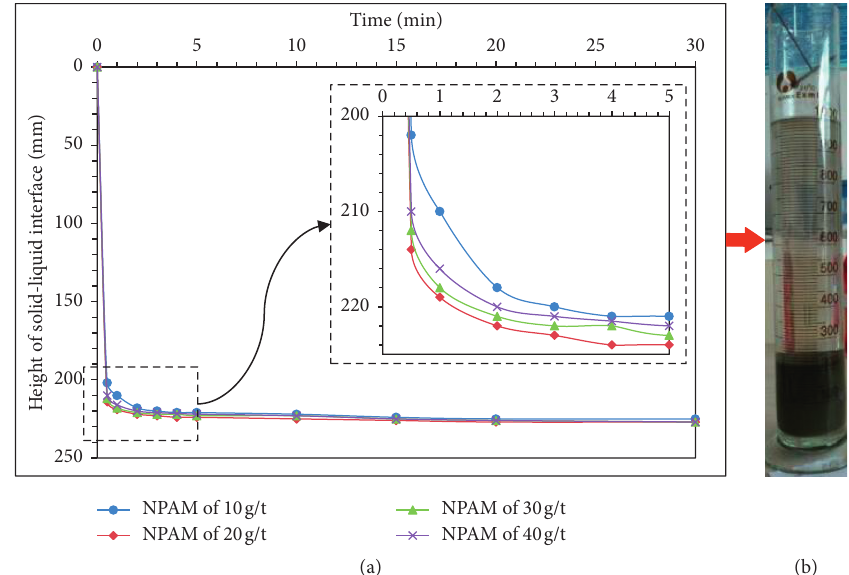
Figure 7: (a) Height variation of the solid-liquid interface with time when the addition of sulfuric acid was 2.6 kg/t and the APAM changed from 10g/t to 40 g/t; (b) experimental effect at sulfuric acid of 2.6kg/t and APAM of